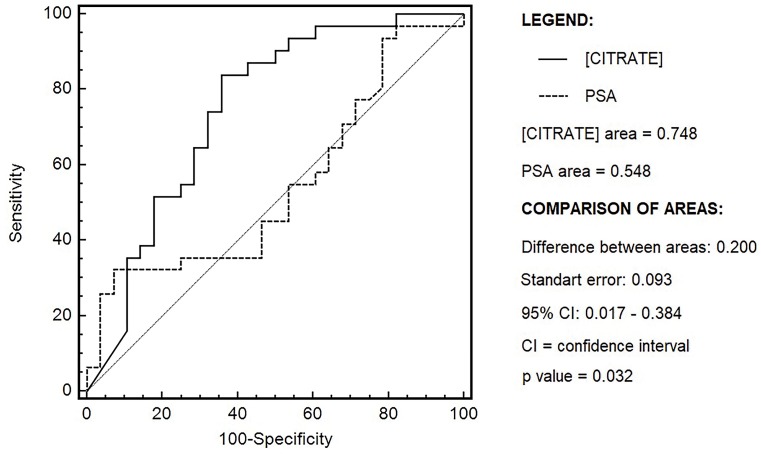
ROC curves corresponding to variables [CITRATE] and PSA and comparison of the areas under the curve.